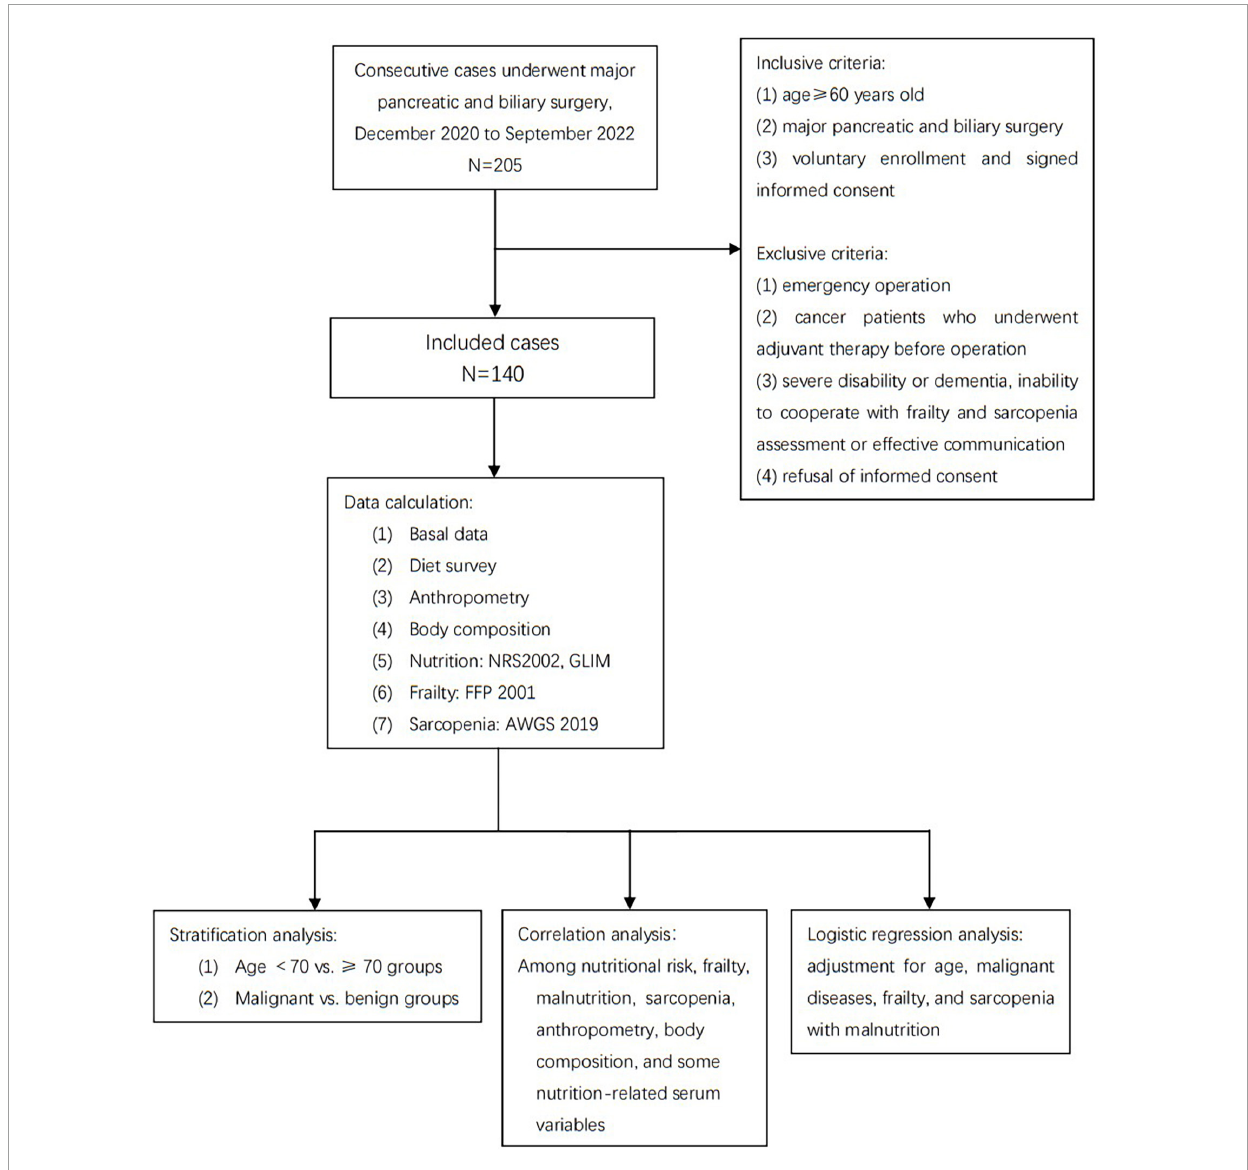
FIGURE1 Flowchart of the